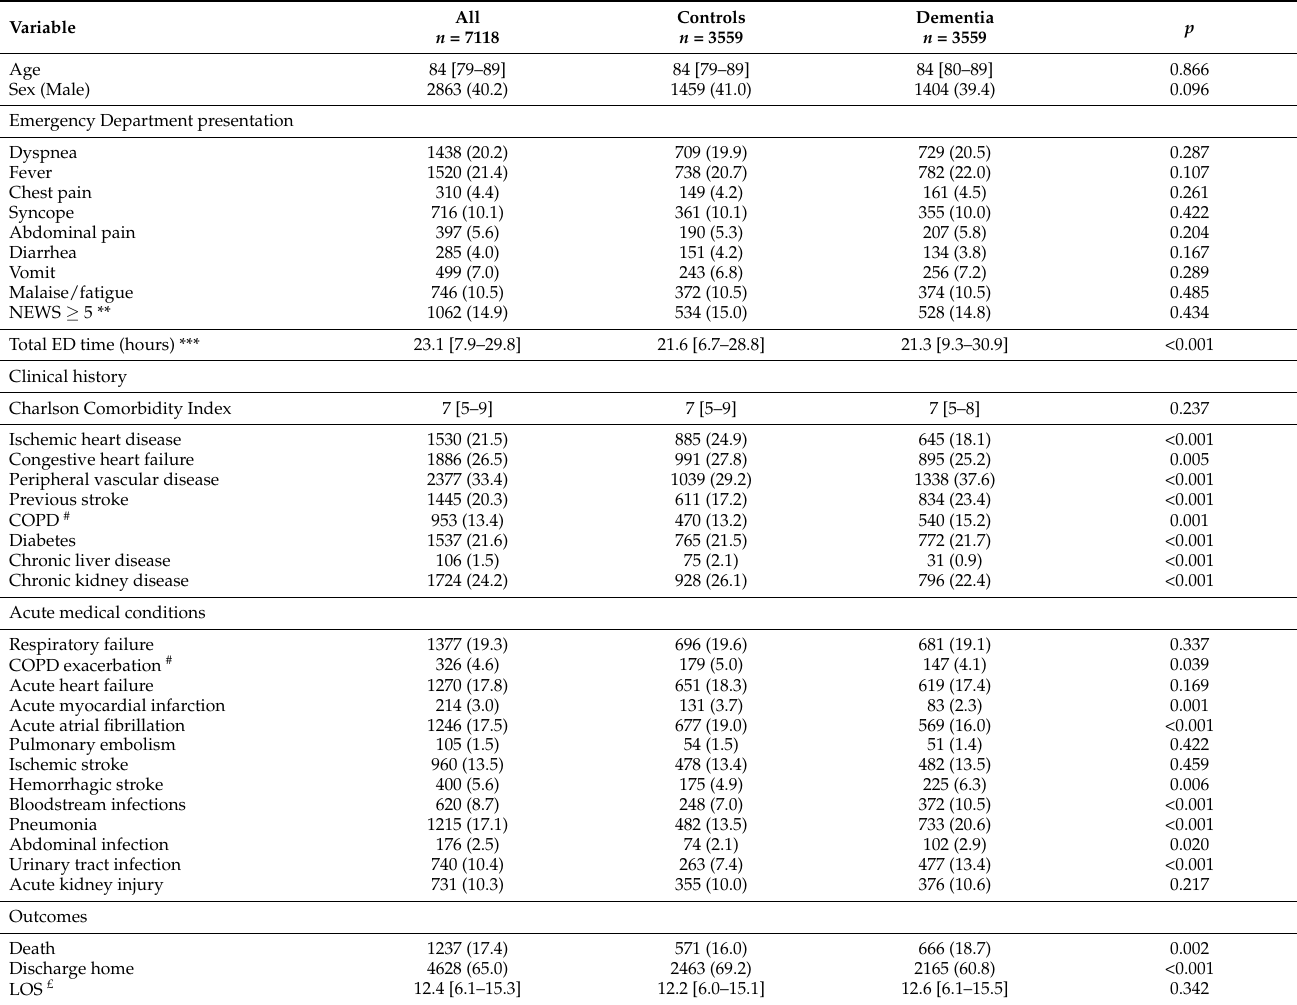
Table 2. Population demographics of adults ≥ 65 years admitted to the Emergency Department (ED) and subsequently hospitalized. Comparison of patients with dementia and patients with no cognitive impairment